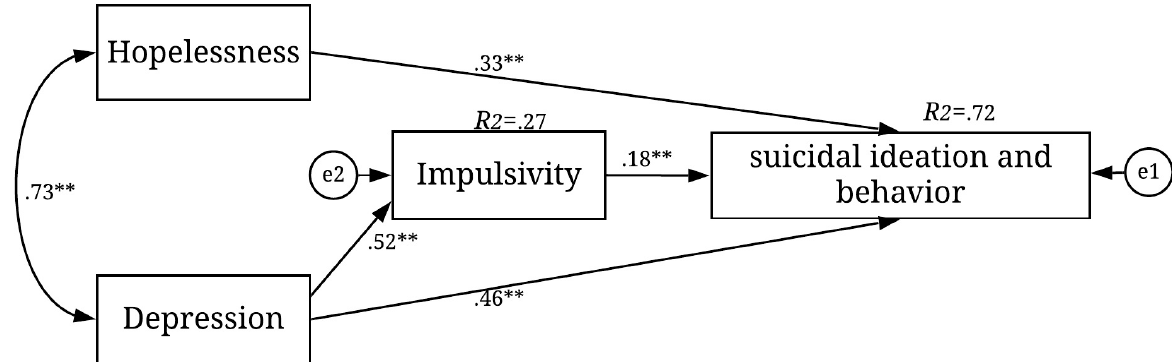
Figure 1. Mediation of impulsivity on the symptoms of depression. ** p<.